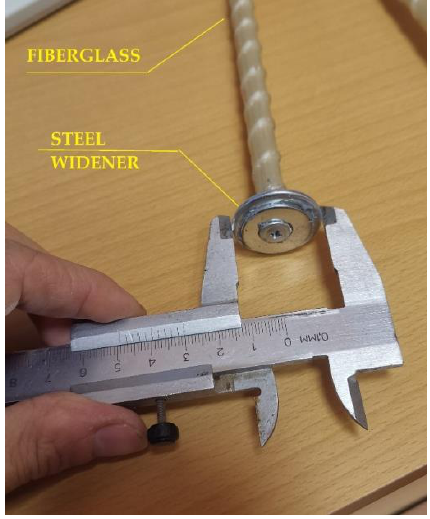
Figure 1. Fiberglass reinforcing elements.